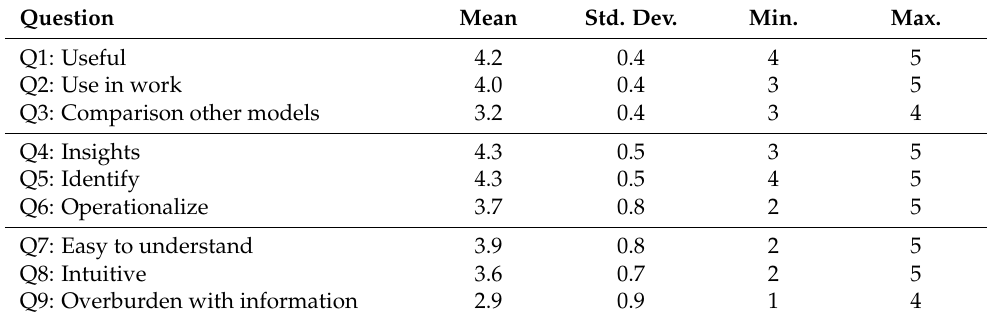
Table 4. Descriptive statistics per survey